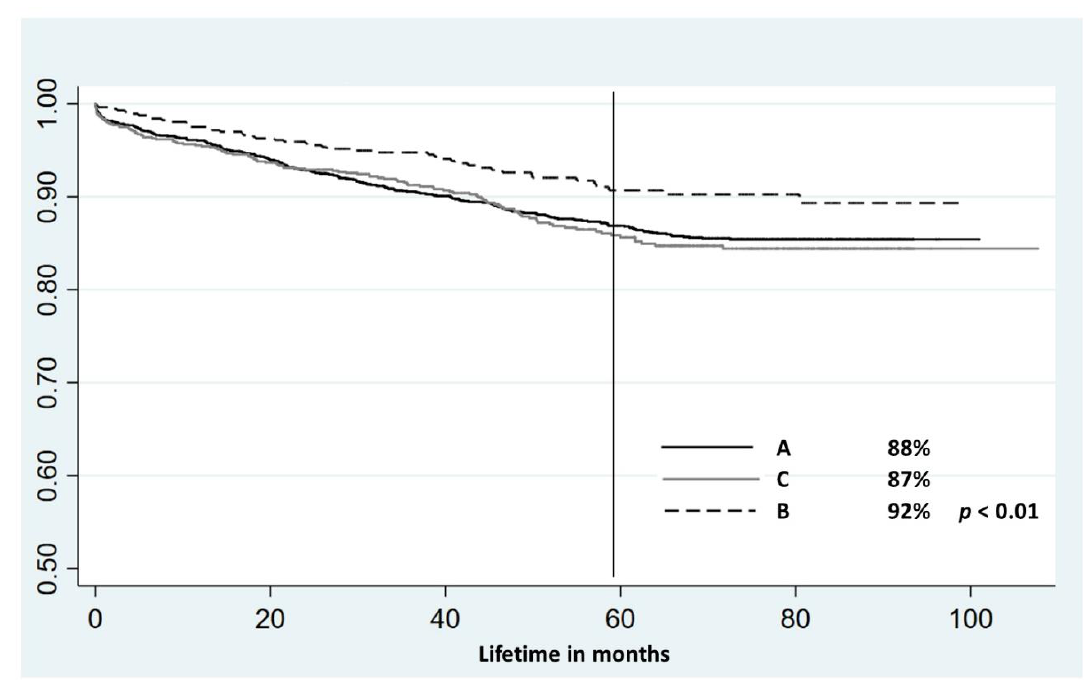
Figure 3. Survival curves for subgroups: 60-month survival in respective subgroups. Legend: Subgroup A—patients without MI who had undergone coronary angiography in the past and who underwent PTCA during the second hospitalization. Subgroup B—patients who had a history of PTCA but did not have a history of myocardial infarction (MI). During the index hospitalization, they had a second PTCA. Subgroup C—patients with past MI and PTCA, who had their second PTCA performed during index